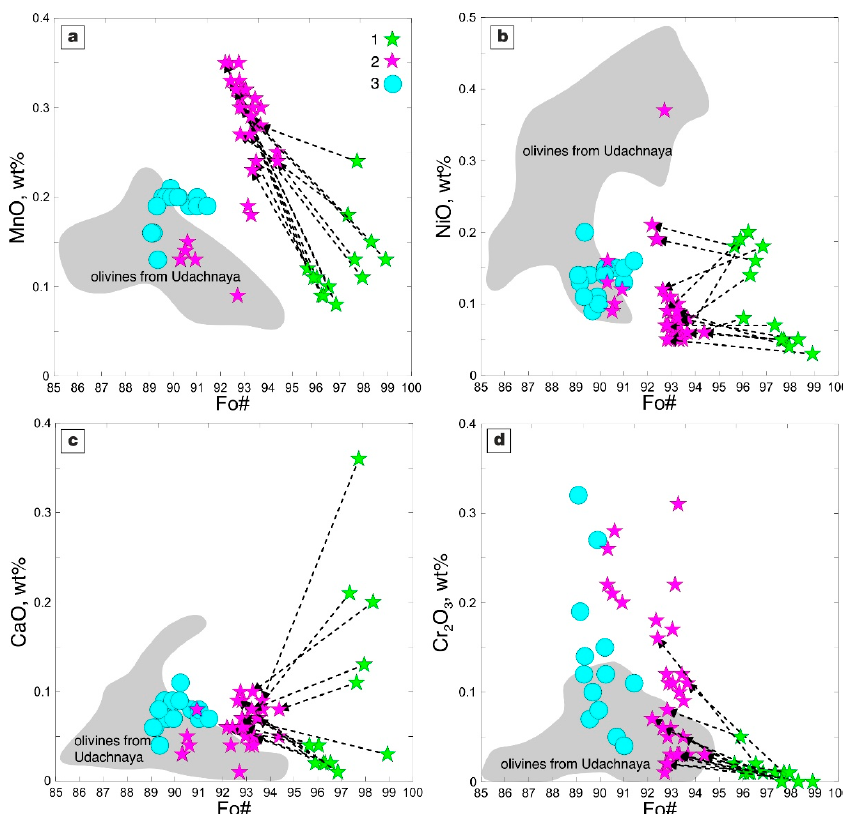
Figure 8. ( a–d ) Co-variation diagrams for olivine grains in the orthopyroxenite. 1—Cores of zoned grains in the crystallized melt inclusions, 2—Rims of zoned grains and homogeneous crystals in the crystallized melt inclusions; 3—Grains in the intergranular space of the rock. Field “Olivines from Udachnaya” comprises published analyses of phenocrystic/xenocrystic olivine and olivine in mantle xenoliths from the Udachnaya kimberlite pipe after [85–91].